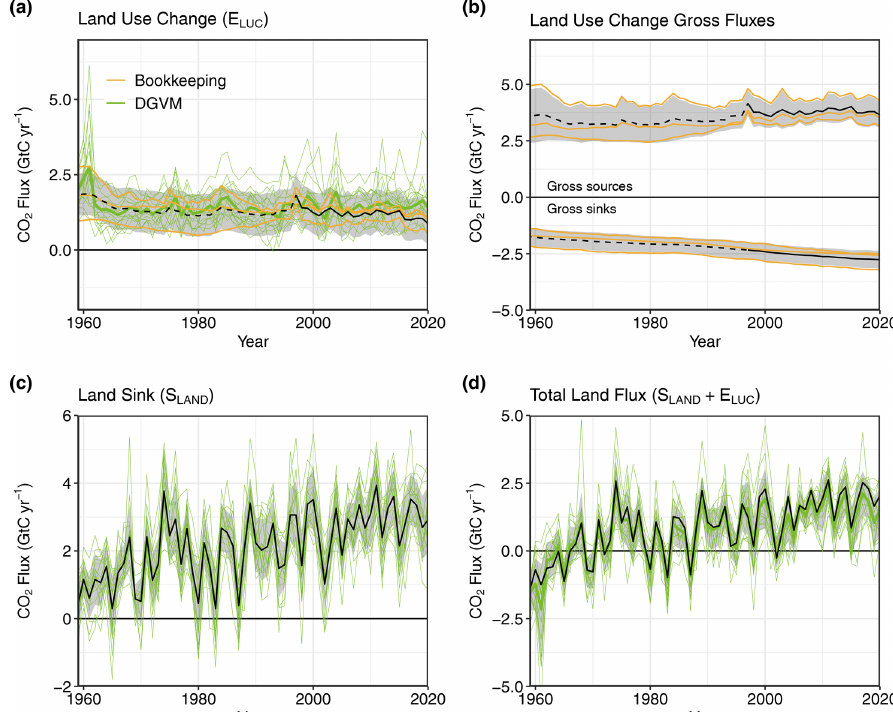
Figure 7. CO 2 exchanges between the atmosphere and the terrestrial biosphere as used in the global carbon budget (black with ± 1 σ uncertainty in grey shading in all panels). (a) CO 2 emissions from land-use change ( E LUC ) with estimates from the three bookkeeping models (yellow lines) and DGVMs (green) shown individually, with DGVM ensemble means (dark green). The dashed line identifies the pre-satellite period before the inclusion of peatland burning. (b) CO 2 gross sinks (positive, from regrowth after agricultural abandonment and wood harvesting) and gross sources (negative, from decaying material left dead on site, products after clearing of natural vegetation for agricultural purposes, wood harvesting, and for BLUE, degradation from primary to secondary land through usage of natural vegetation as rangeland, and also from emissions from peat drainage and peat burning) from the three bookkeeping models (yellow lines). The sum of the gross sinks and sources is E LUC shown in panel (a) . (c) Land CO 2 sink ( S LAND ) with individual DGVM estimates (green). (d) Total atmosphere–land CO 2 fluxes ( S LAND − E LUC ), with individual DGVMs (green) and their multi-model mean (dark